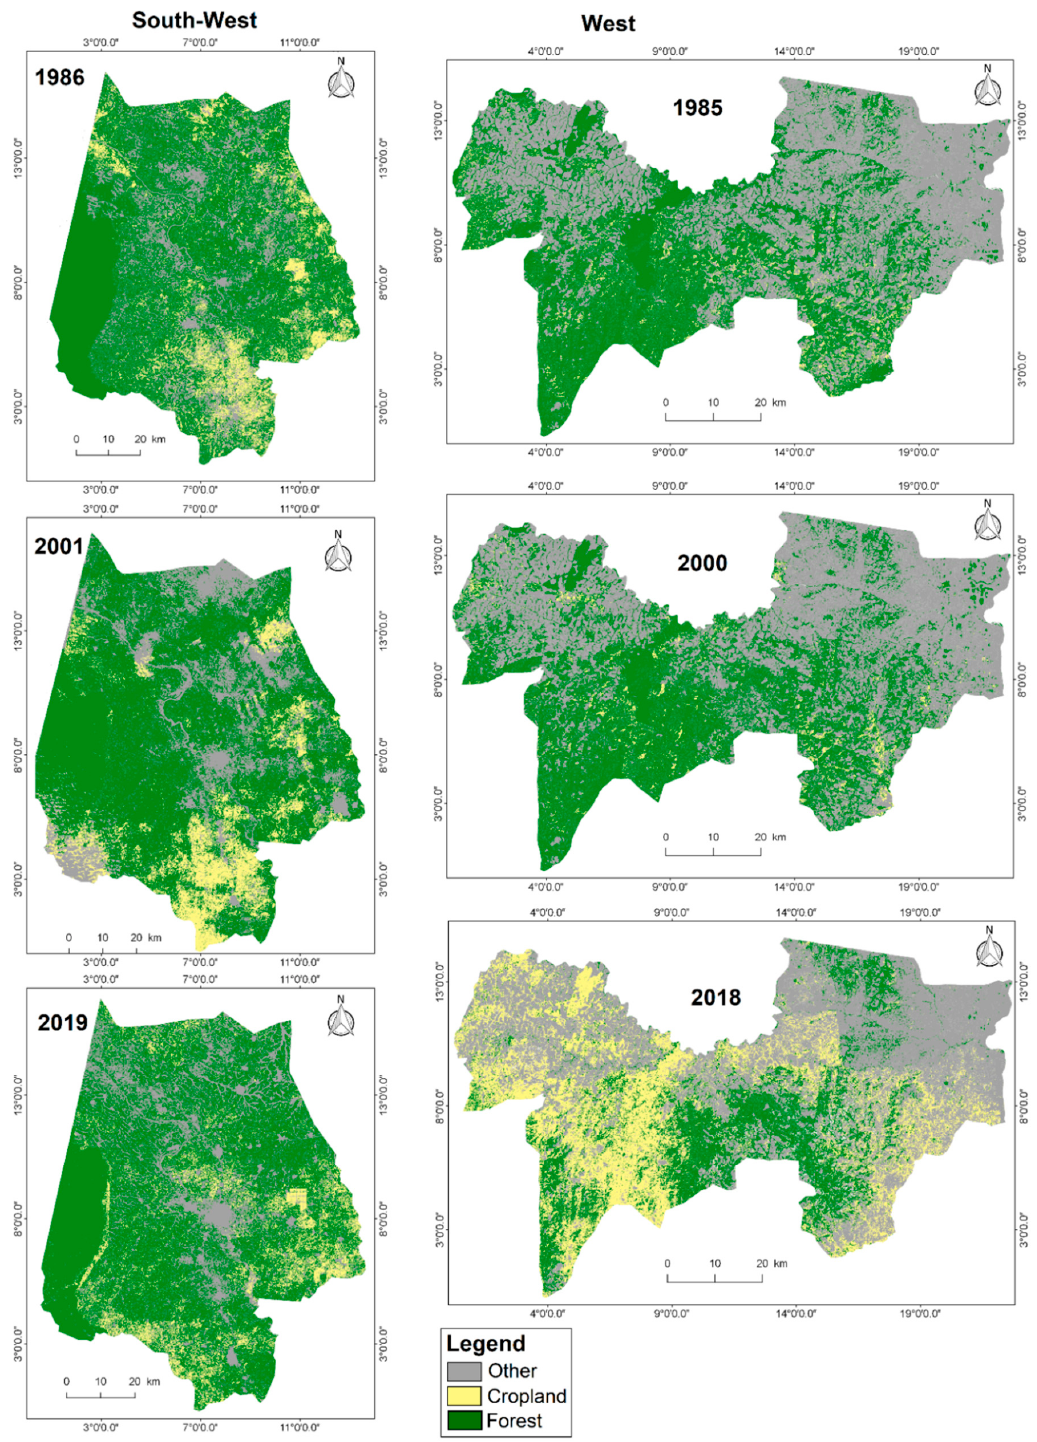
Figure 4. Land-cover maps of the Soubré ( left ) and Biankouma ( right ) regions. Table 3. Proportion (%) of land-cover occupation.